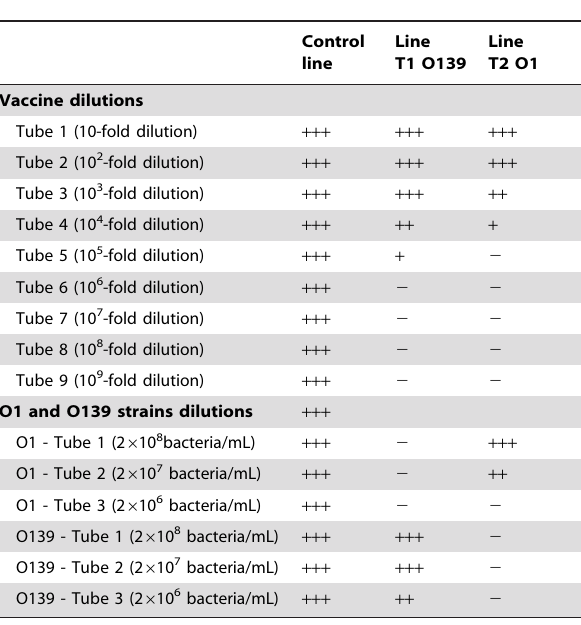
Table 3. Rapid diagnostic test results performed in vaccine and bacterial suspension dilutions, Pasteur Institute,